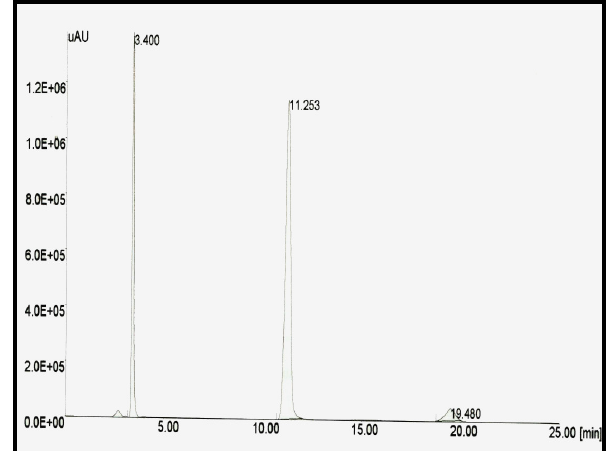
Figure 2. Typical HPLC chromatogram.